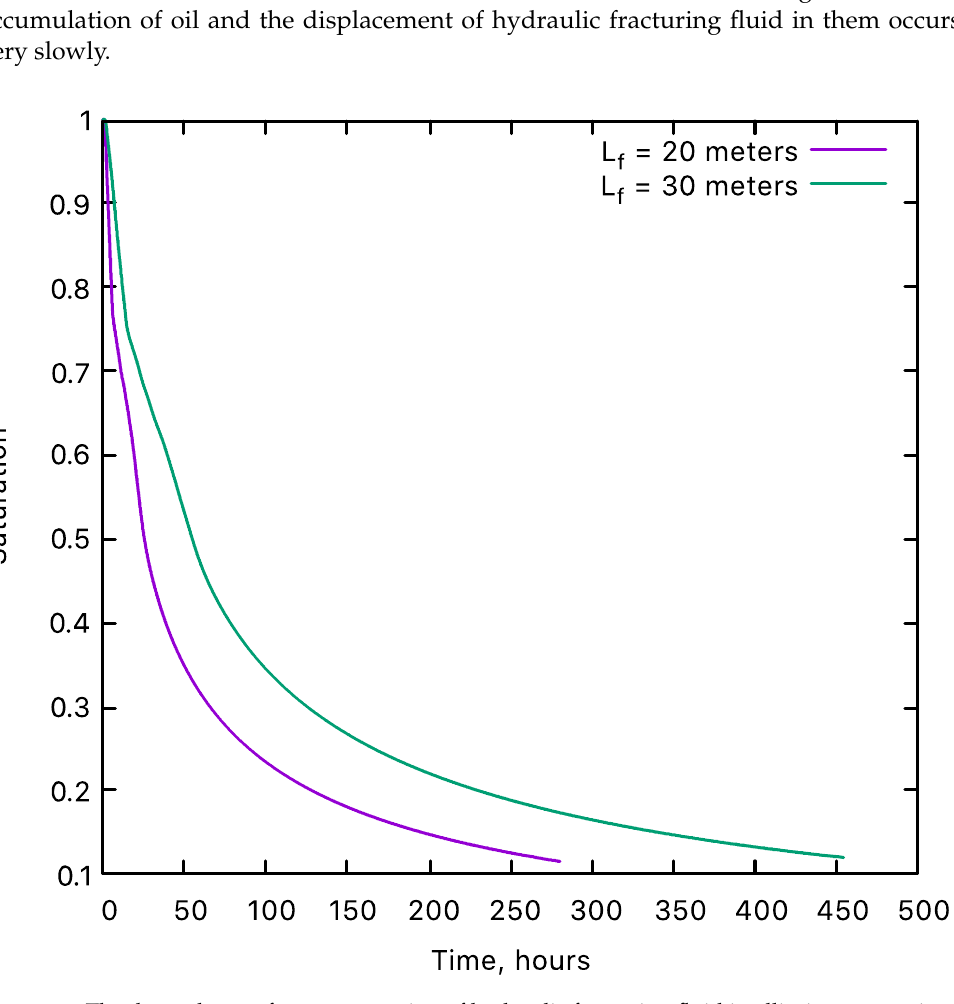
Table 3. Calculation parameters for the first numerical experiment with different fracture lengths.